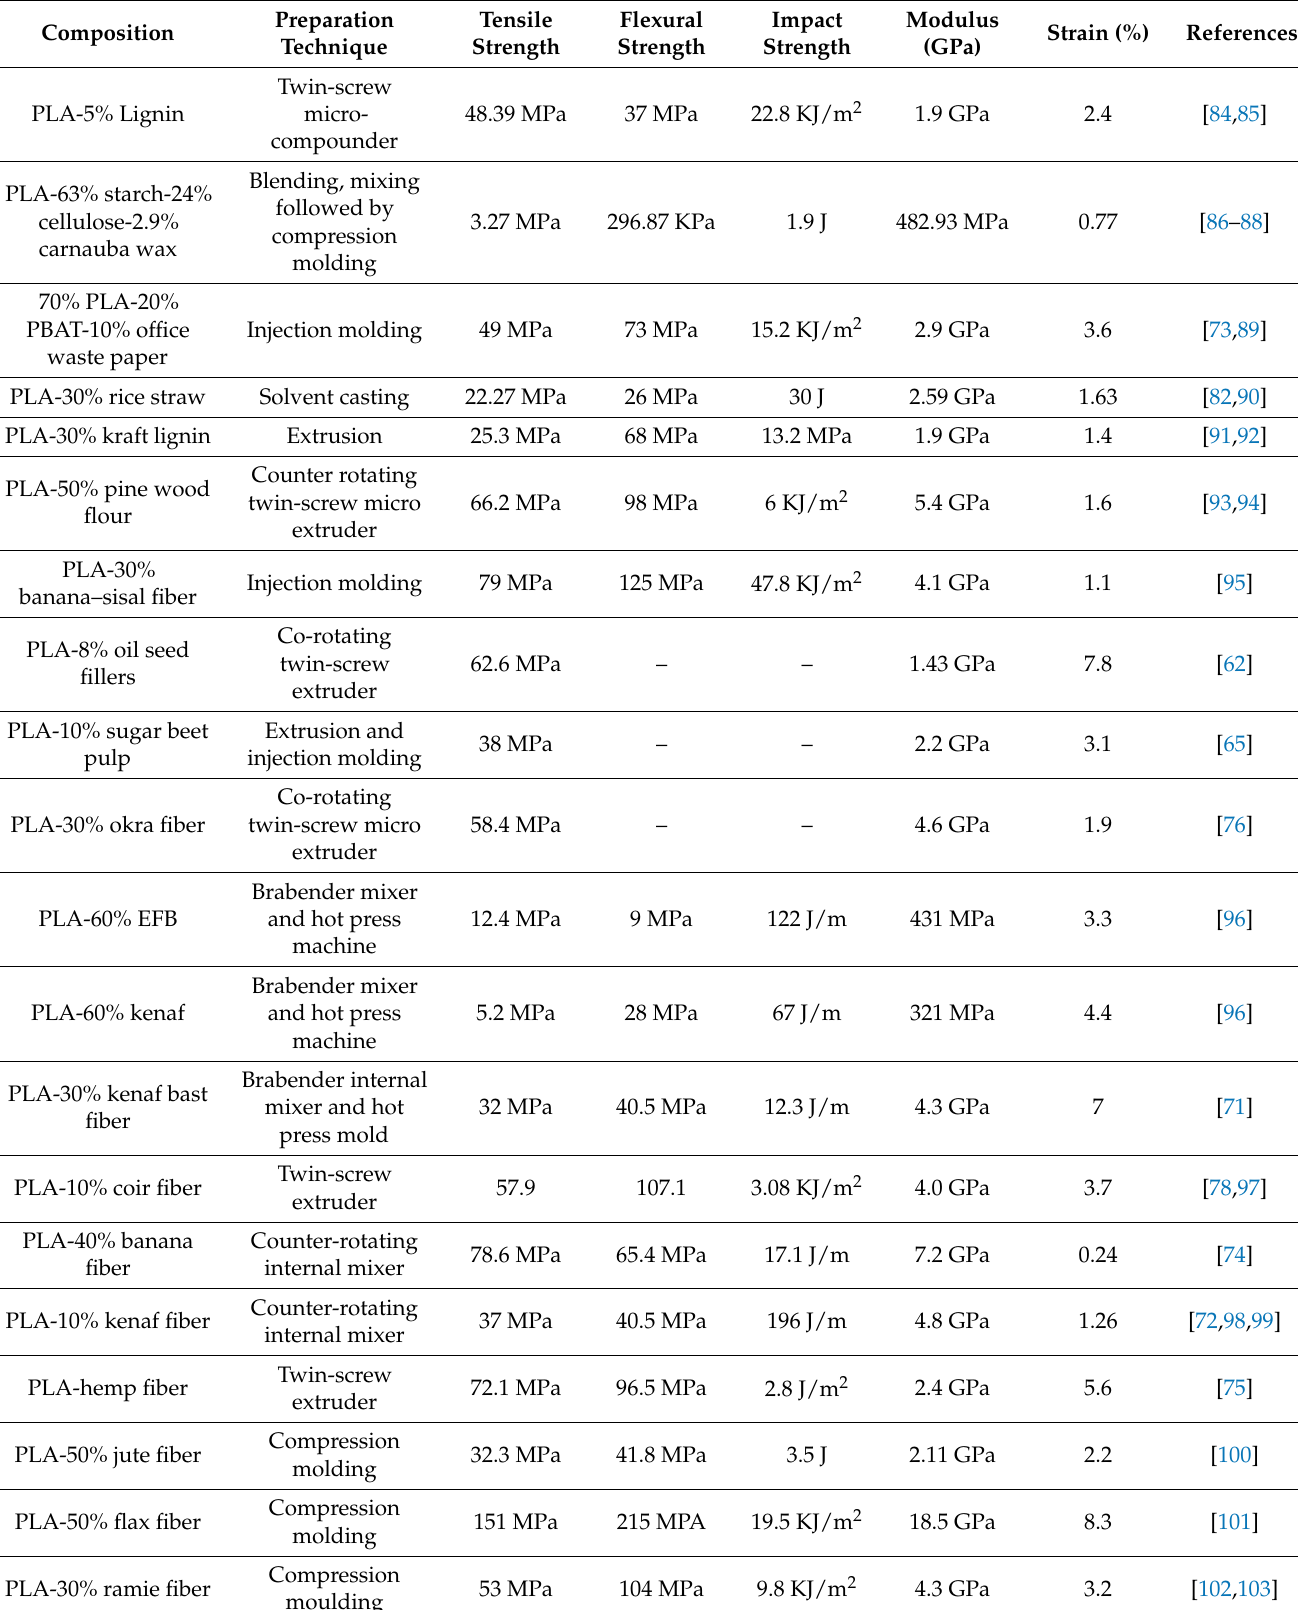
Table 4. Mechanical properties of PLA